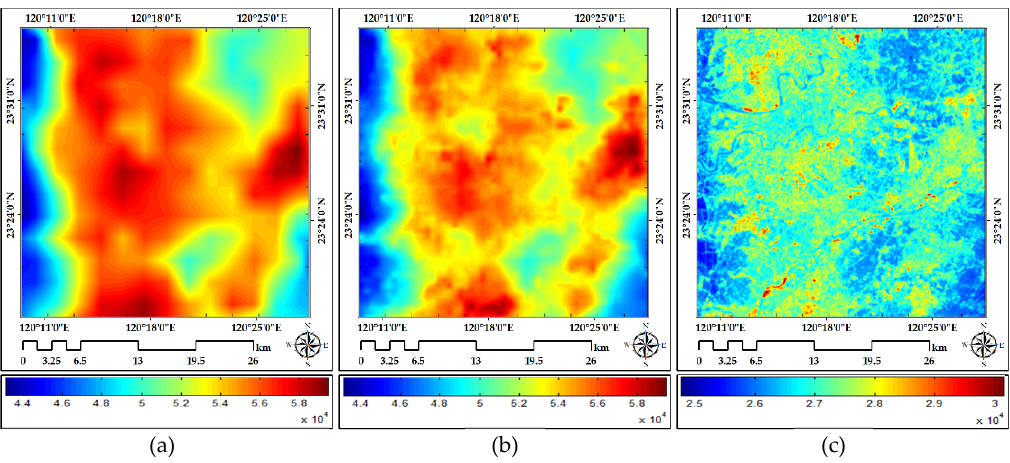
Figure 3. Digital number of Himawari-8 TIR images ( a ) without sharpening and ( b ) with sharpening, compared to ( c ) the digital number of the Landsat-8 TIR image at the same acquisition time (15 November 2018).